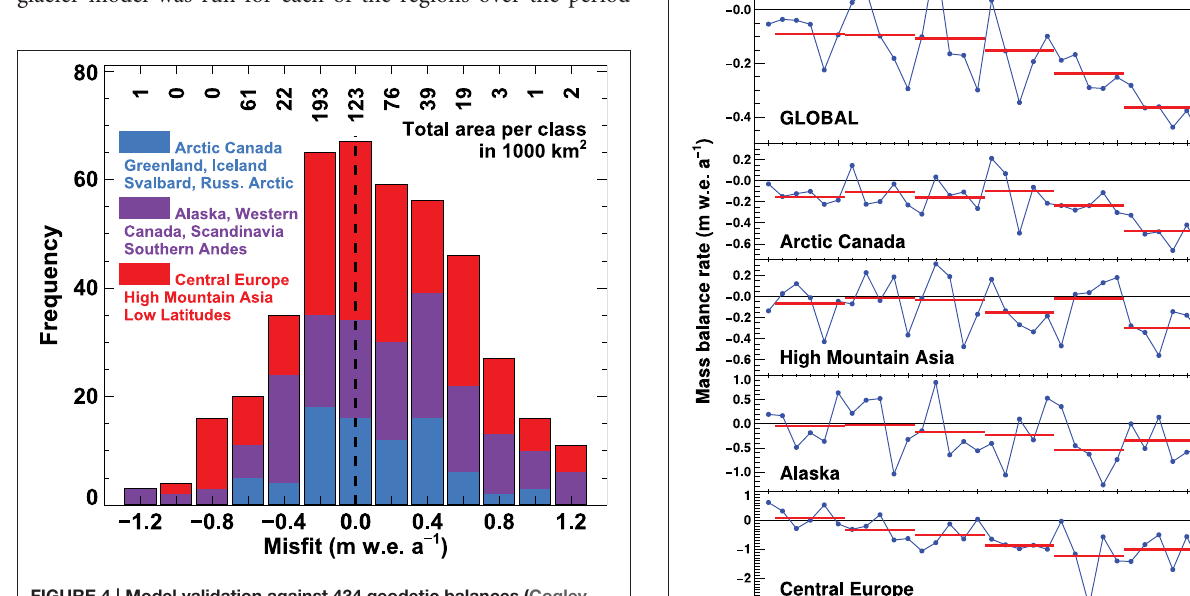
Frontiers in Earth Science |